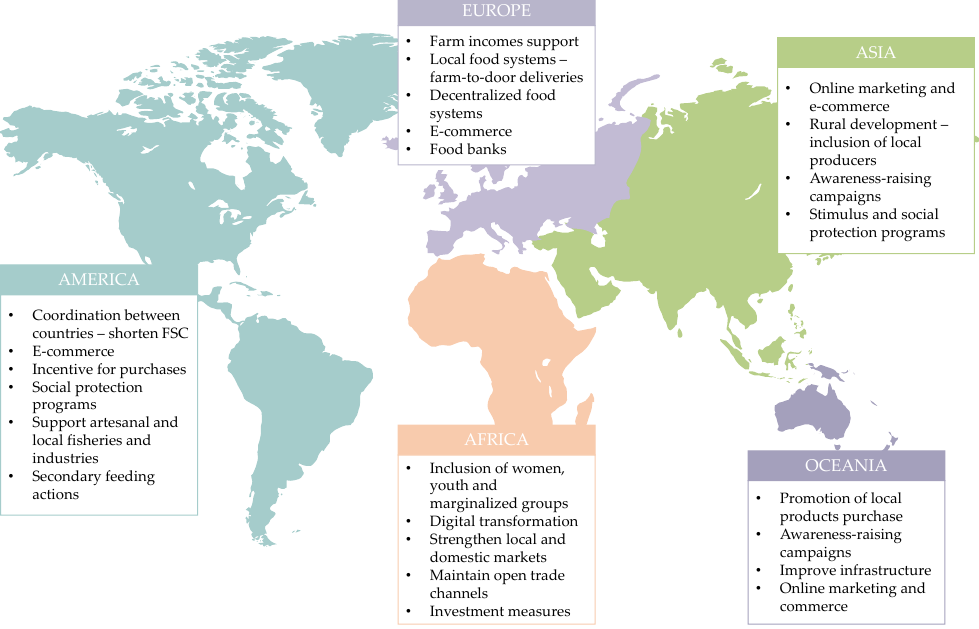
Figure 2. Some strategies and actions to deal with FLW generation and achieve the recovery of the food sector during COVID-19.